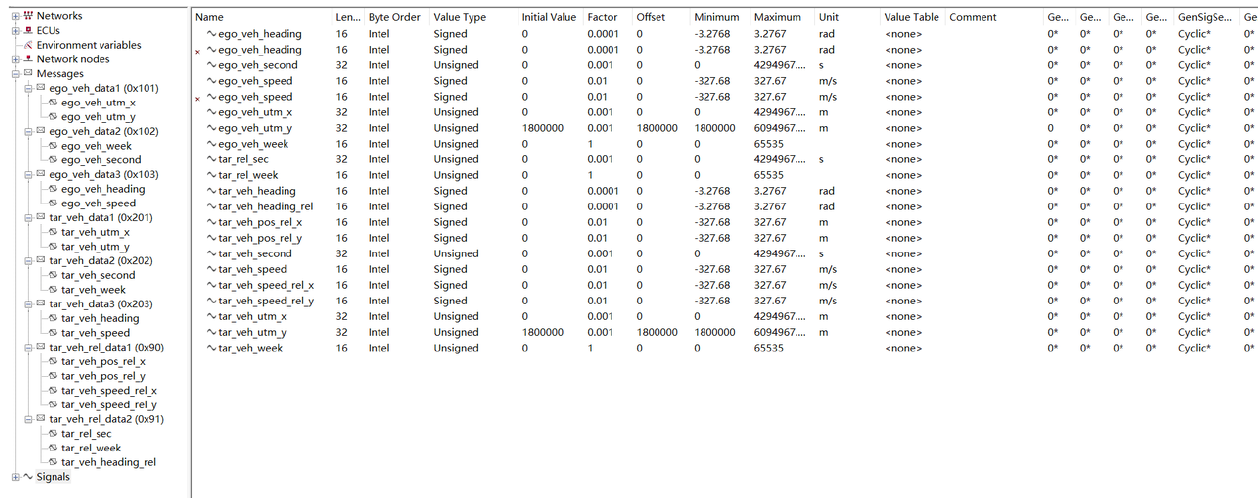
Figure 15. The CAN signal.